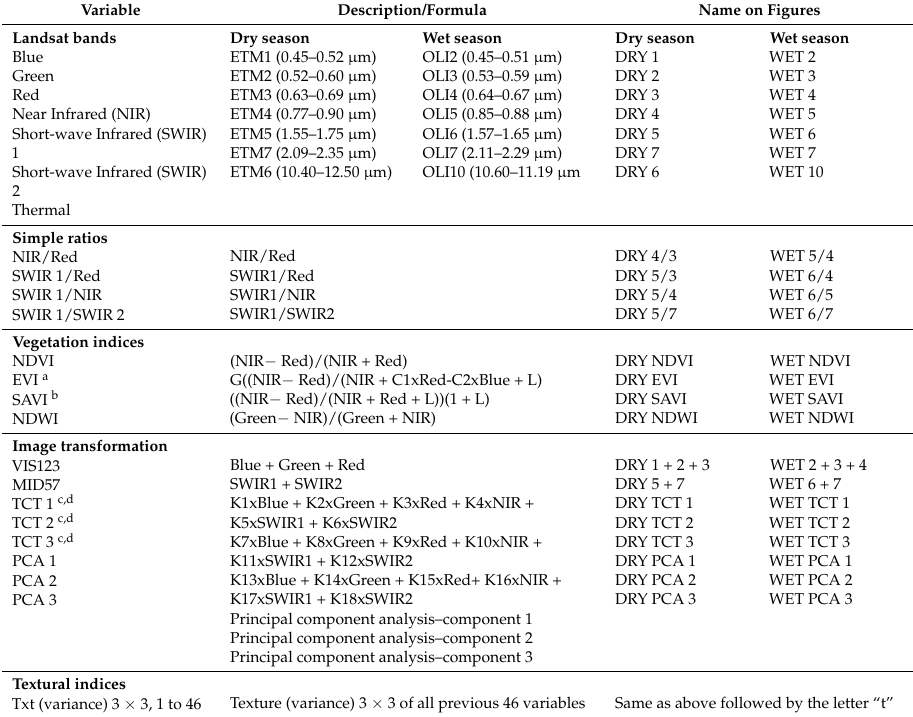
Table 1. Predictor variables used in Random forests (RF) classifications. Variables were calculated independently for the dry and wet seasons. The last column specifies the names used to identify variables elsewhere in this manuscript. ETM = Enhanced Thematic Mapper, OLI = Operational Land